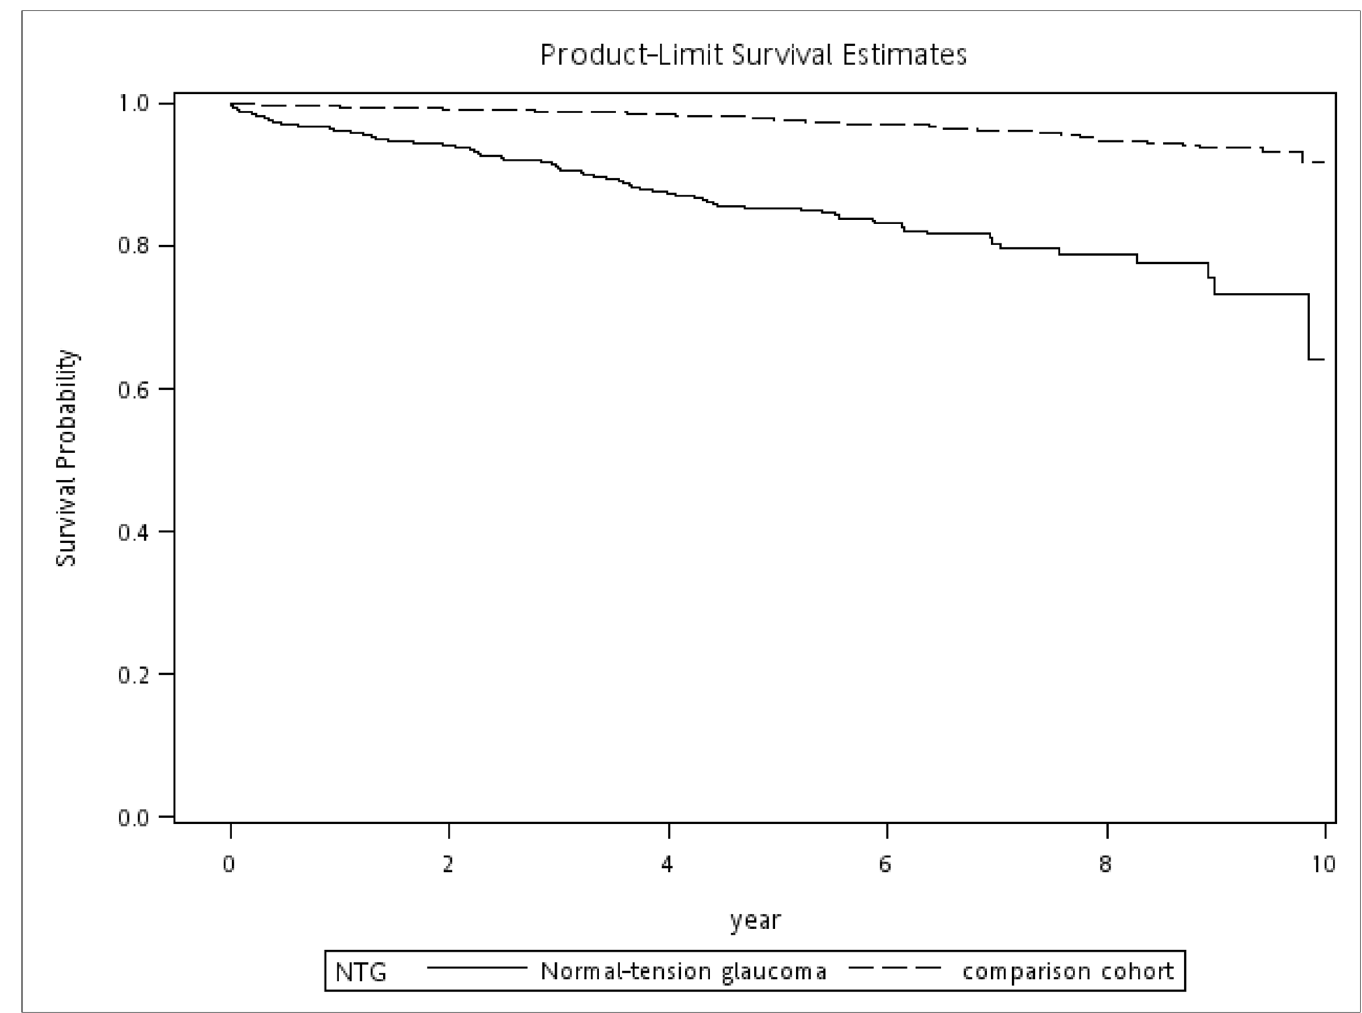
Fig 1. Stroke-free survival rates for NTG patients and comparison group in Taiwan, 2001 to 2010. The stratified log-ranktest also indicatedthat patients with NTG had significantly lower stroke-free survival rates than comparison group ( P < .0001).